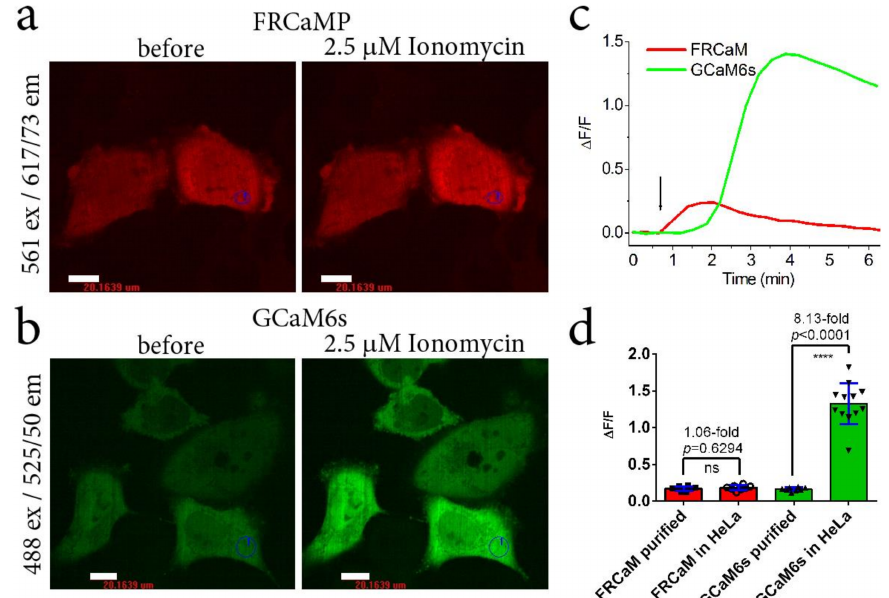
Figure 6. Calcium-dependent response of the truncated versions (with a deleted M13-like peptide) of the FRCaMP (FRCaM) and GCaMP6s (GCaM6s) indicators in HeLa cells. Confocal images